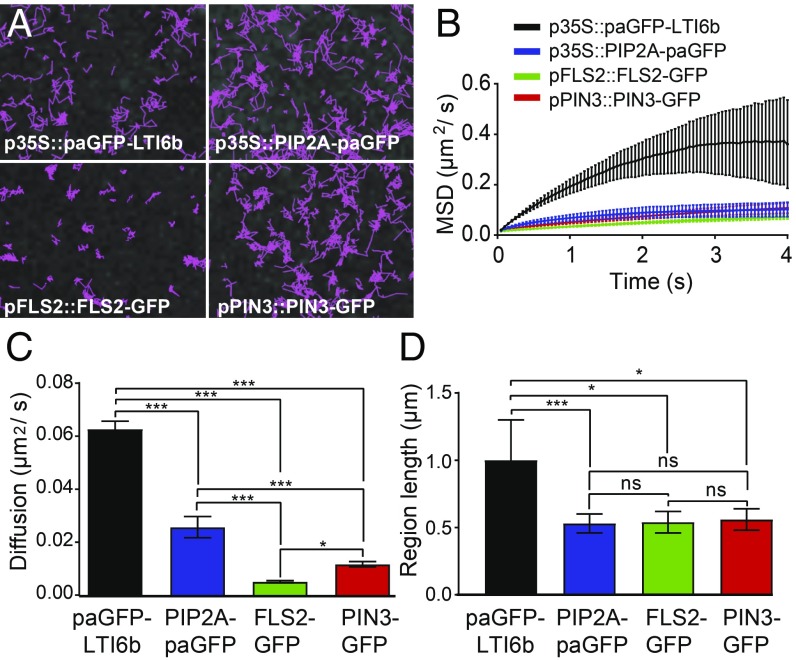
TIRF-SPT imaging of PM proteins. (A) TIRF-SPT of PM proteins in the hypocotyl membrane. Images show tracks followed by single labeled particles over 60 s. Some proteins, e.g., FLS2-GFP, are much more constrained in their lateral mobility than others. (B) Mean square displacement curves. Curves that fall below a straight line corresponding to the initial gradient (as these all do) represent constrained diffusive movement. Error bars indicate bootstrap-estimated SD. (C) Constrained diffusion rate (µm2/s) of proteins in the membrane. All tested proteins differ. (D) Constrained region length (µm) of proteins in the membrane. *P < 0.05, ***P < 0.01; ns, not significant.